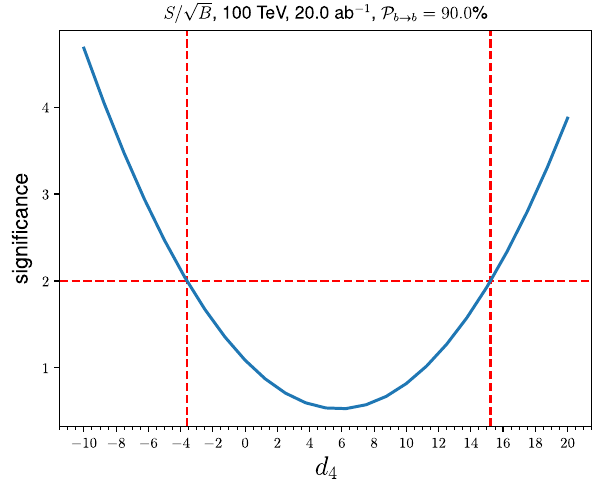
Fig. 12 ThesignificanceforouranalysisoftripleHiggsbosonproduc- tion in the ( b ¯ b )( b ¯ b )( b ¯ b ) final state with modified quartic self-coupling ( λ 4 = λ SM ( 1 + d 4 ) ) and no modification to the triple self-coupling ( c 3 = 0) at the FCC-hh at 100 TeV. We have assumed an integrated luminosity of 20 ab − 1 and b -tagging of 90%. The red dashed lines indicate the 2 σ points for the constraints on d 4